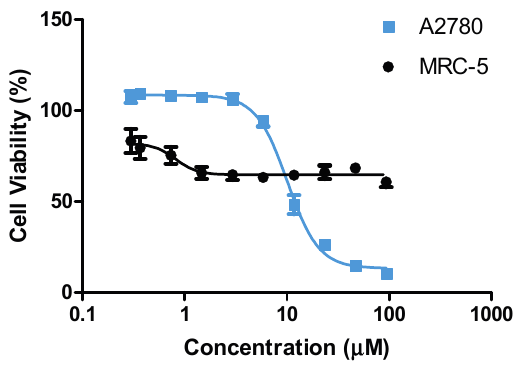
Figure 4. Anti-proliferative activity of LTi toward non-cancerous human lung MRC-5 cells, and human ovarian cancer A2780 cells demonstrated for comparison. IC 50 values could not be calculated because the compound did not reach 50% inhibition of cell